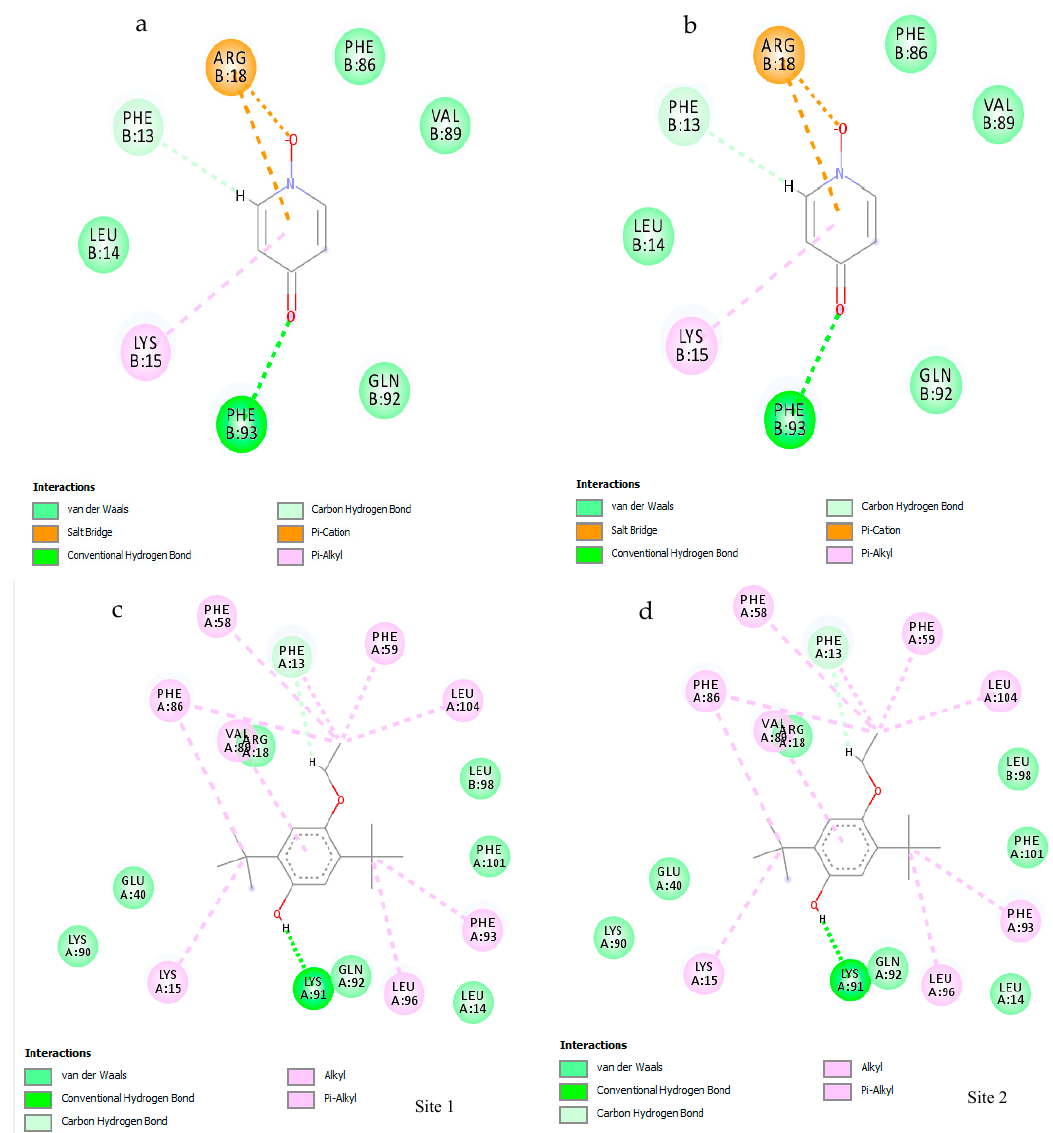
Figure 4. Two-dimensional interaction diagram for the protein – ligand complex. Interactions of the five active sites situated within the survivin protein and the phenol,2,5-bis (1,1-dimethylethyl) ligand ( a , b ) and with survivin and the 4-hydroxypyridine 1-oxide ligand ( c , d ). Both active sites of the phenol,2,5-bis (1,1-dimethylethyl) ligand showed an approximately similar glide docking score of − 5.449 kcal/moL and − 5.269 kcal/moL. Two-dimensional analysis of the active site showed the involvement of one strong hydrogen bond with Lys91 residue and a number of van der Waals forces between the ligand and the residues from the protein (Figure 5a,b).